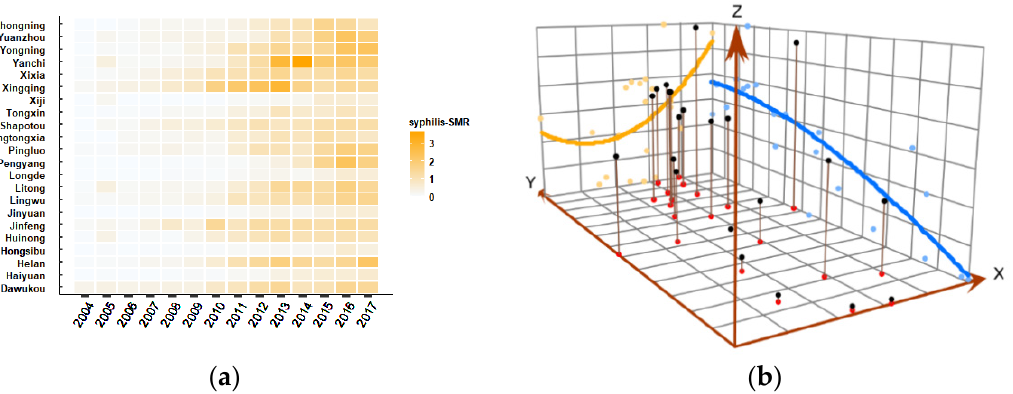
Figure 1. Syphilis in 22 administrative areas of Ningxia, China. ( a ) Heat map of SMR of syphilis in 22 administrative areas of Ningxia, ( b ) spatial three-dimensional trend surface analysis of the mean SMR of syphilis in Ningxia (SMR: standardized morbidity ratio). The blue and yellow lines are the trend fitting lines of syphilis SMR in the north–south and east–west directions, respectively.